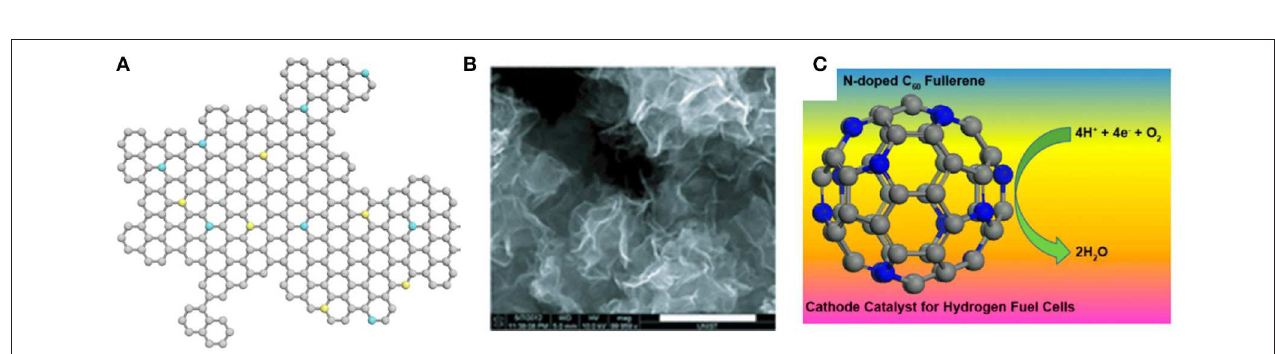
FIGURE 2 | (A) Thermal behavior of GO paper for repeated cooling and heating cycles between 30 ◦ C and 80 ◦ C. (B) The process of the water adsorption/desorption process in GO paper (reprinted with permission from Zhu et al. (2012). Copyright 2012 American Chemical Society). (C) The process of absorption/desorption of water molecules in GO sheet (reproduced from Qiu et al. (2018) with permission from The Royal Society of Chemistry).